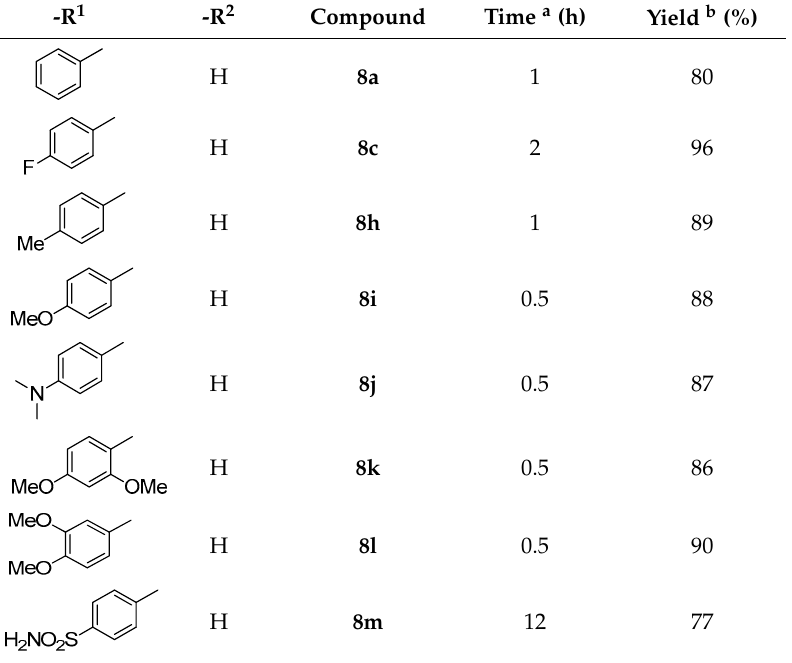
Table 4. Chemical structures and yields obtained for the sequential MCR-synthesis of 8a , 8c and 8h – m via Cu catalysed intramolecular cyclization.